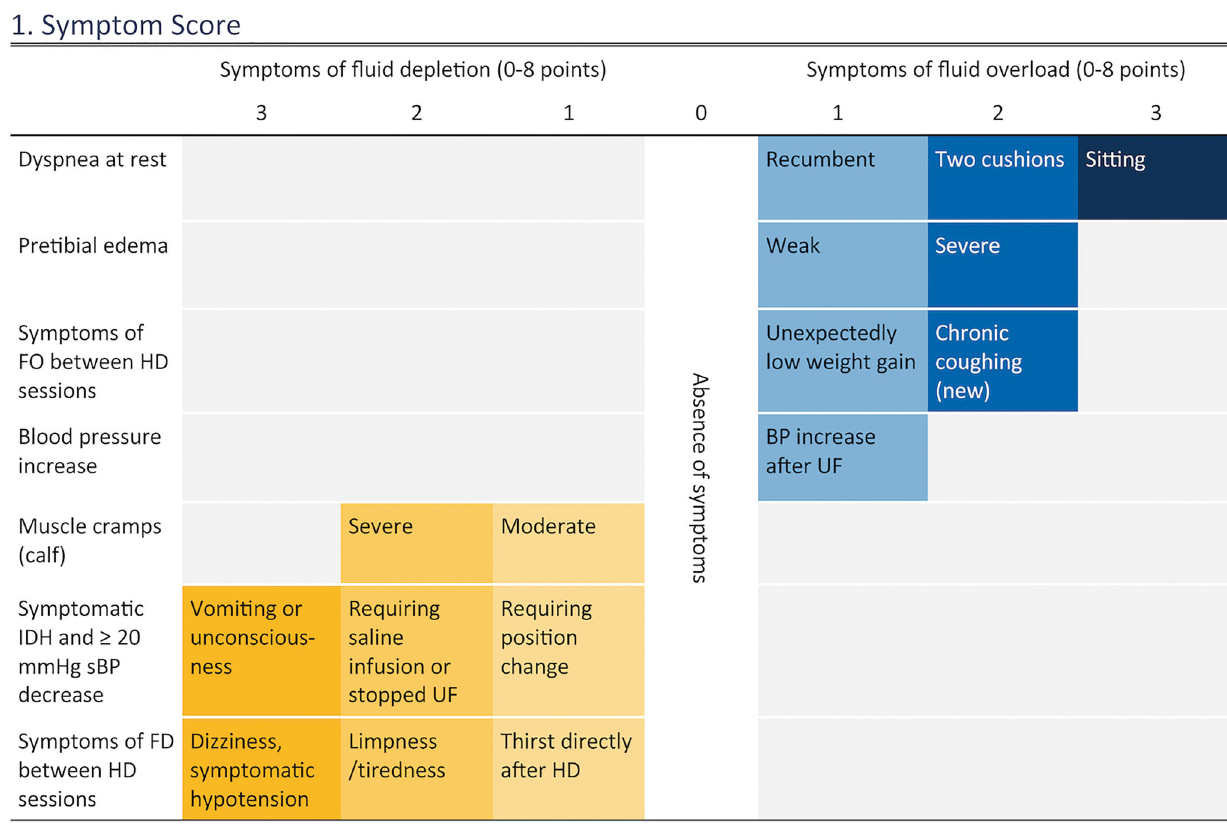
Figure 1. The Recova V R scoring system for systemized clinical assessment of fluid status (from Reference [18]). The symptom score can total 0 – 16 points: 0 – 8 fluid overload points and 0 – 8 fluid depletion